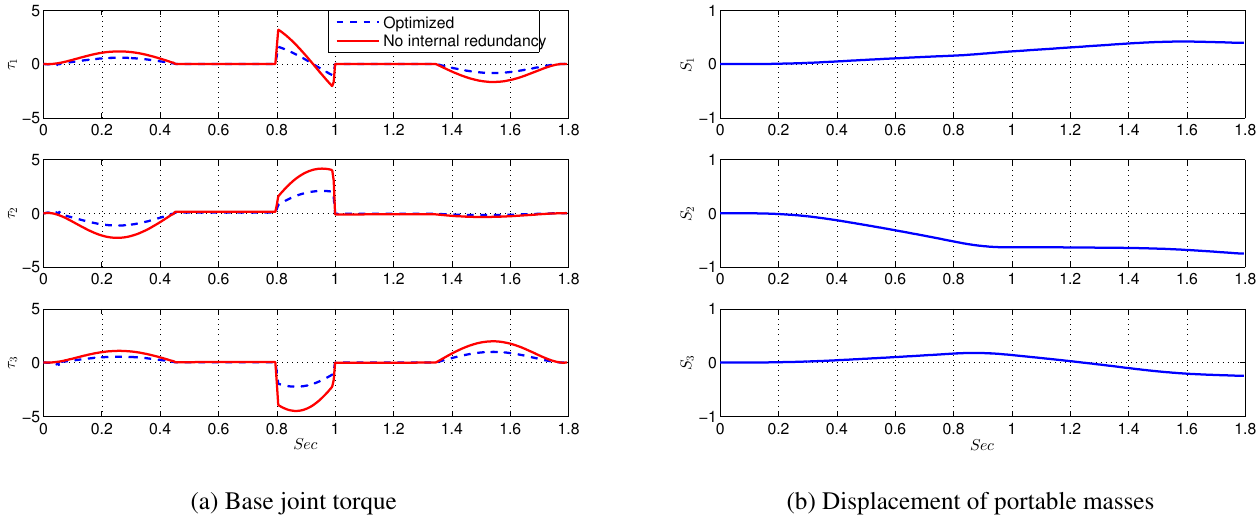
Figure 5. The torques of the ground actuators (in Nm) and displacement of the portable masses (in m) for r = 0 . 025m and λ = 0 . 5. Fig. 5: The torques of the ground actuators (in N.m) and displacement of the portable masses (in m) for r = 0 . 025 m and λ = 0 . 5 . in Fig. 5b where they are initial at 0 and are allowed to move redundancy. As greater improvement of the torques requires between − 1 and